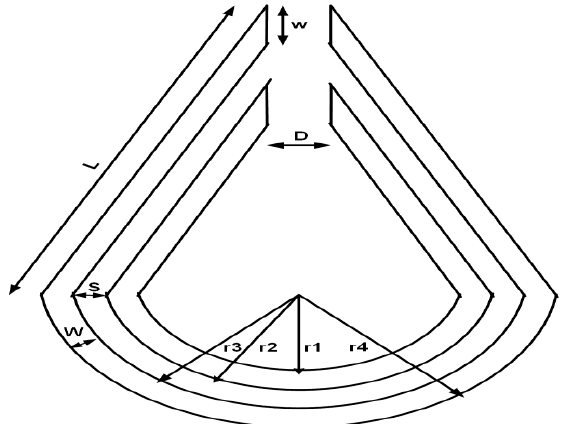
Figure 1: Geometry of Split Semi-Horse Shoe Structure